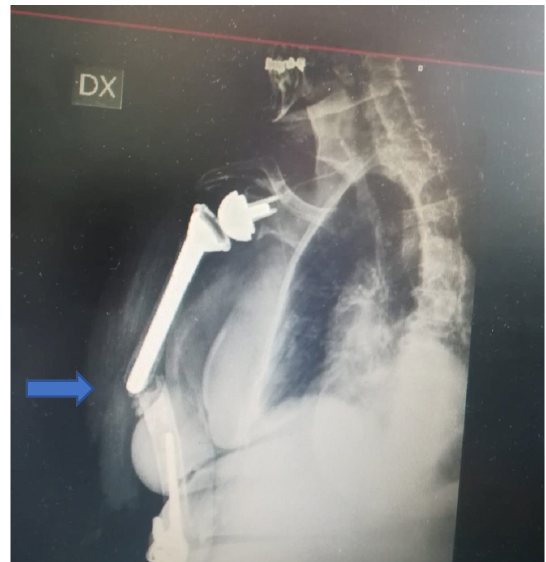
Figure 1. X ‐ ray at admission. Complex fracture between a stemmed cemented reverse shoulder ar ‐ throplasty and elbow arthroplasty associated with severe bone